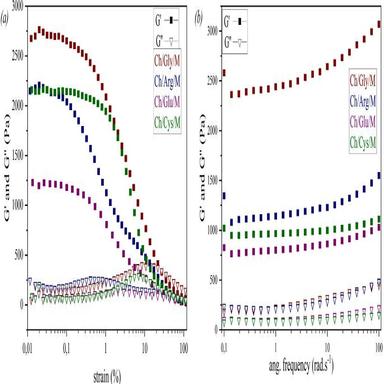
Rheological properties of the materials at constant frequency (a) and strain (b).